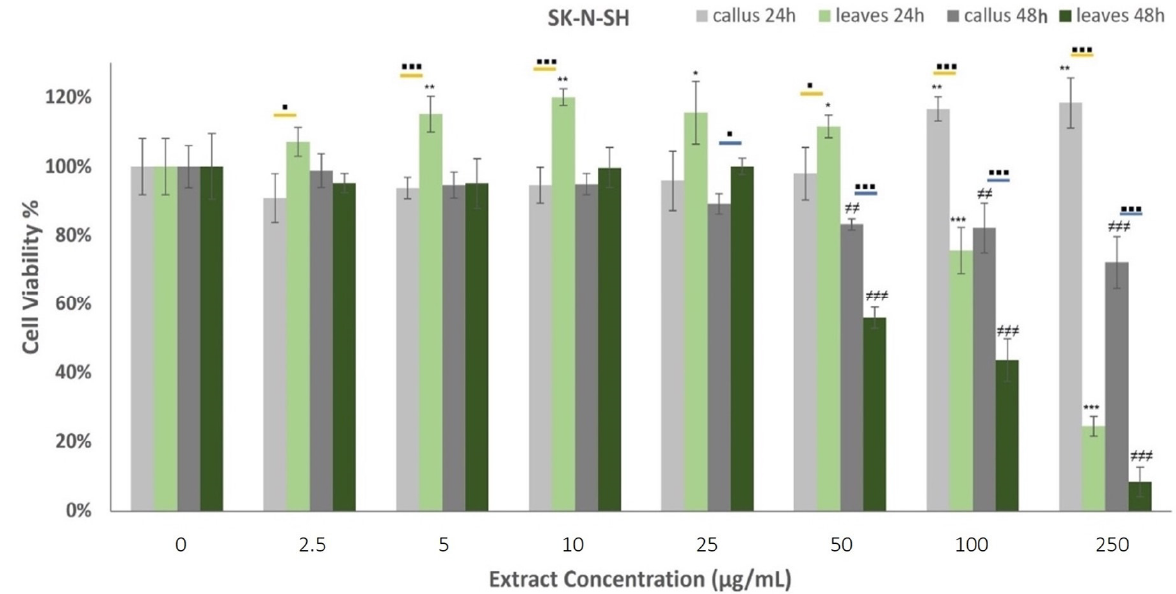
Figure 6. Percentage of SK-N-SH cells’ viability after treatment with extracts derived from oregano callus and leaves at concentrations of 2.5, 5, 10, 25, 50, 100, and 250 µ g/mL, for 24 h and 48 h. Average results from replicate experiments ± SD ( n = 6). The * indicates statistically significant differences from the control for the 24 h incubation, ≠ indicates statistically significant differences from the con- trol for the 48 h incubation, and ▪ indicates statistically significant differences between callus and leaf extract when administered at the same concentration (yellow line for the 24 h incubation and blue line for the 48 h). Significant differences (Student’s t -test) between normalized cell responses * ≠ ▪ p < 0.05., ** p < 0.01, *** ≠≠≠ ▪▪▪ p < 0.001.